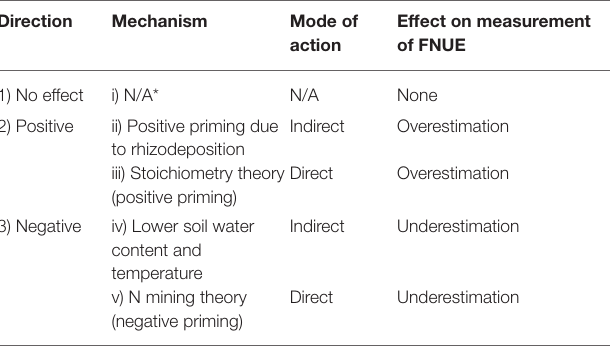
TABLE 1 | Potential directions and mechanisms of effects of synthetic nitrogen (N) fertilizer addition on SOM mineralization and the respective impacts on